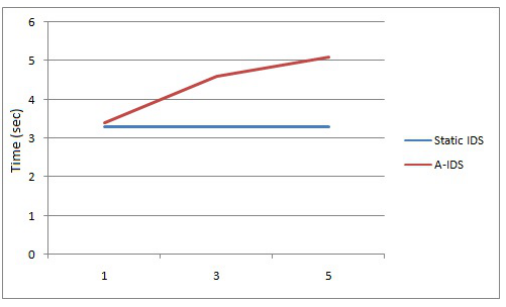
Figure 10. Approximate execution